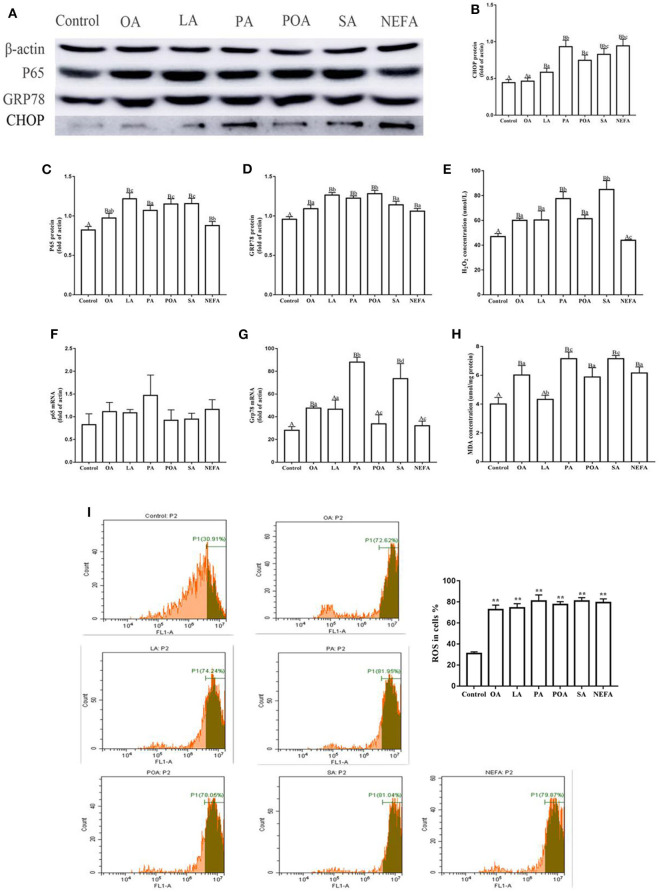
Effects of different fatty acids on stress and inflammatory response of primary hepatocytes. Cells were treated with 1.2 mM fatty acids for 12 h (n = 3 ell preparations). (A) β-actin, P65, GRP78, and CHOP protein expression were assayed by western blotting. Gray-shaded bars represent the amount (%) of β-actin, P65, GRP78, and CHOP in primary hepatocytes. (B–D) CHOP, P65, and GRP78 protein expression in primary hepatocytes were assayed by western blotting and reported relative to β-actin. (F,G) P65 and GRP78 mRNA expression were assayed by real-time RT-qPCR. (I) ROS were assayed by fluorescence microscopy and flow cytometry. Fluorescence intensity is proportional to ROS activity in primary hepatocytes. **p < 0.01 solvent and control group. (E,H) H2O2 (μmol/L) and MDA (μmol/mg protein) were assayed using commercial kits. Four assays were independently performed in each group. Uppercase letter vs. control p ≤ 0.05, lowercase letter vs. fatty acid group p ≤ 0.05, the same letter vs. no letter mark p ≥ 0.05.